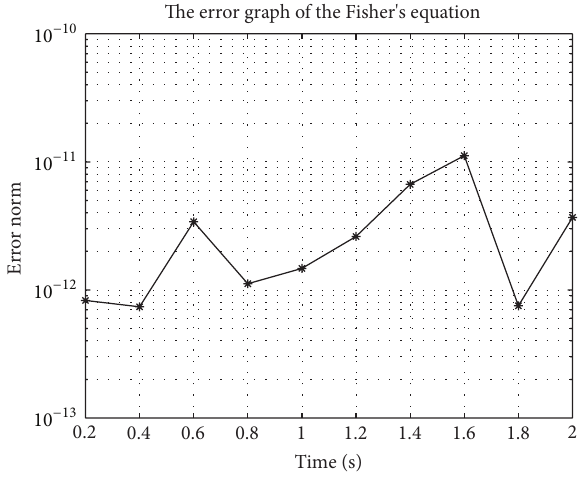
Figure 7: Fishers equation error graph.